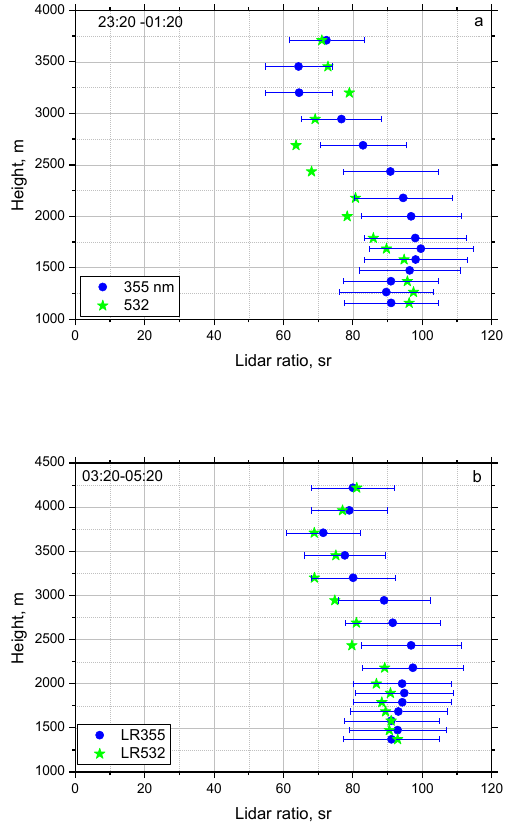
Figure 8. Lidar ratios at 532 and 355nm for time interval (a) 23:20– 01:20 and (b) 03:20–05:20UTC on 27–28 August.